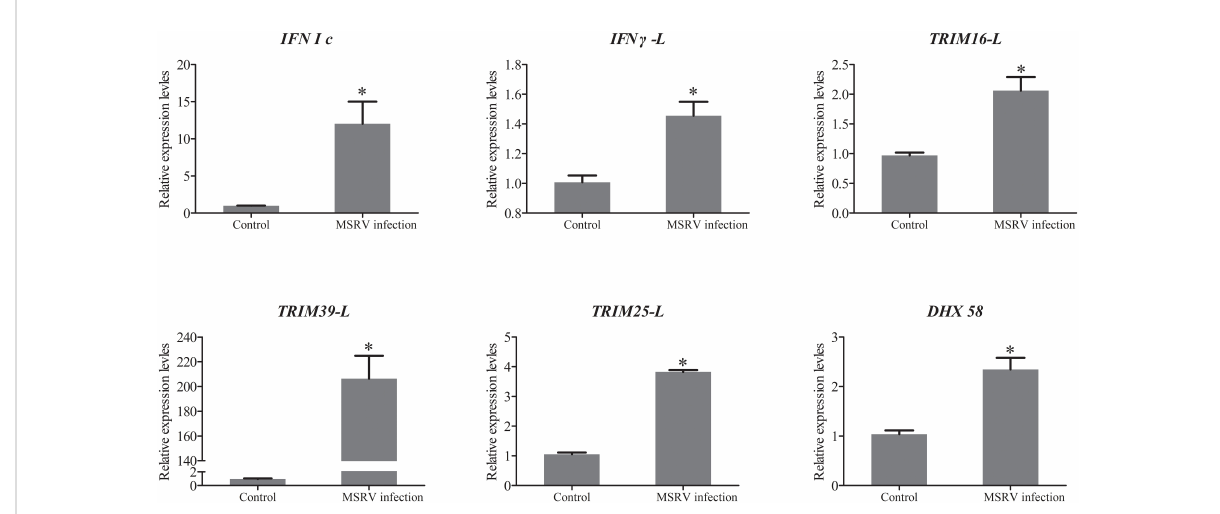
FIGURE 4 The qRT-PCR analysis of expression of genes involved in Interferon related genes and RIG-I-like receptor genes following MSRV infection. Asterisk represented statistical signi fi cance between infection group and control group. ( p <